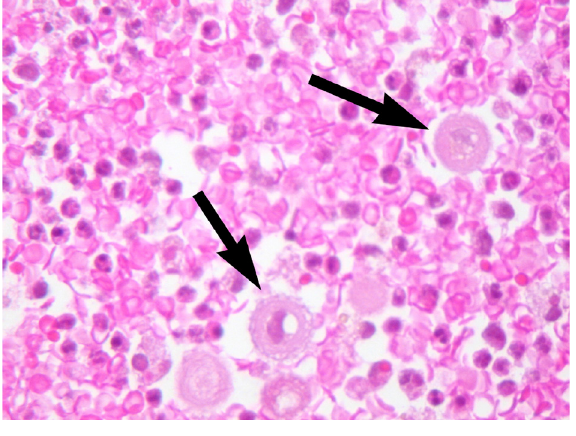
Figure 2. Fragment of epithelial tissue associated with inflam- matory cells and erythrocytes (H&E 400x).